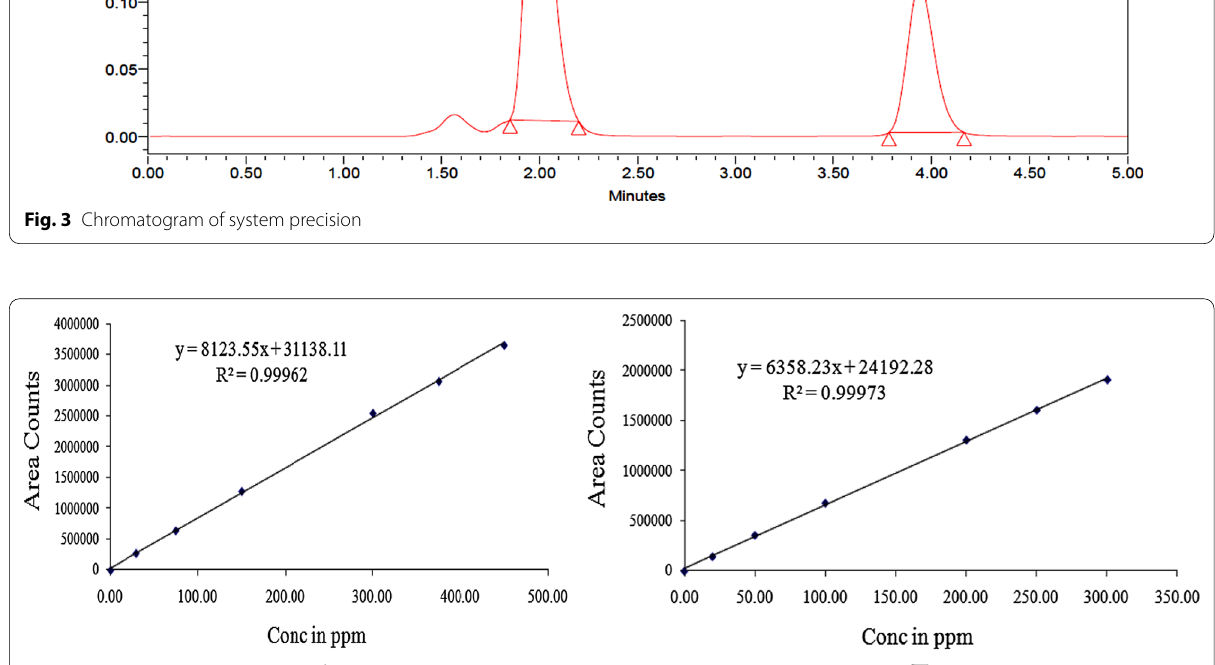
Fig. 4 Calibration curve of A Rilpivirine, B Cabotegravir